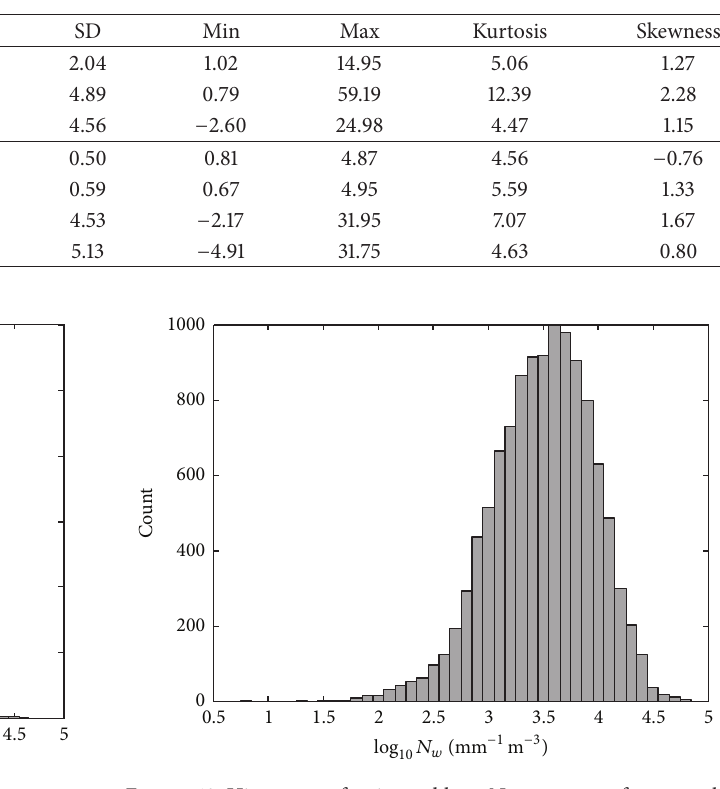
Figure 13: Histogram of estimated log 10 𝑁 𝑤 parameter for normal- ized Gamma